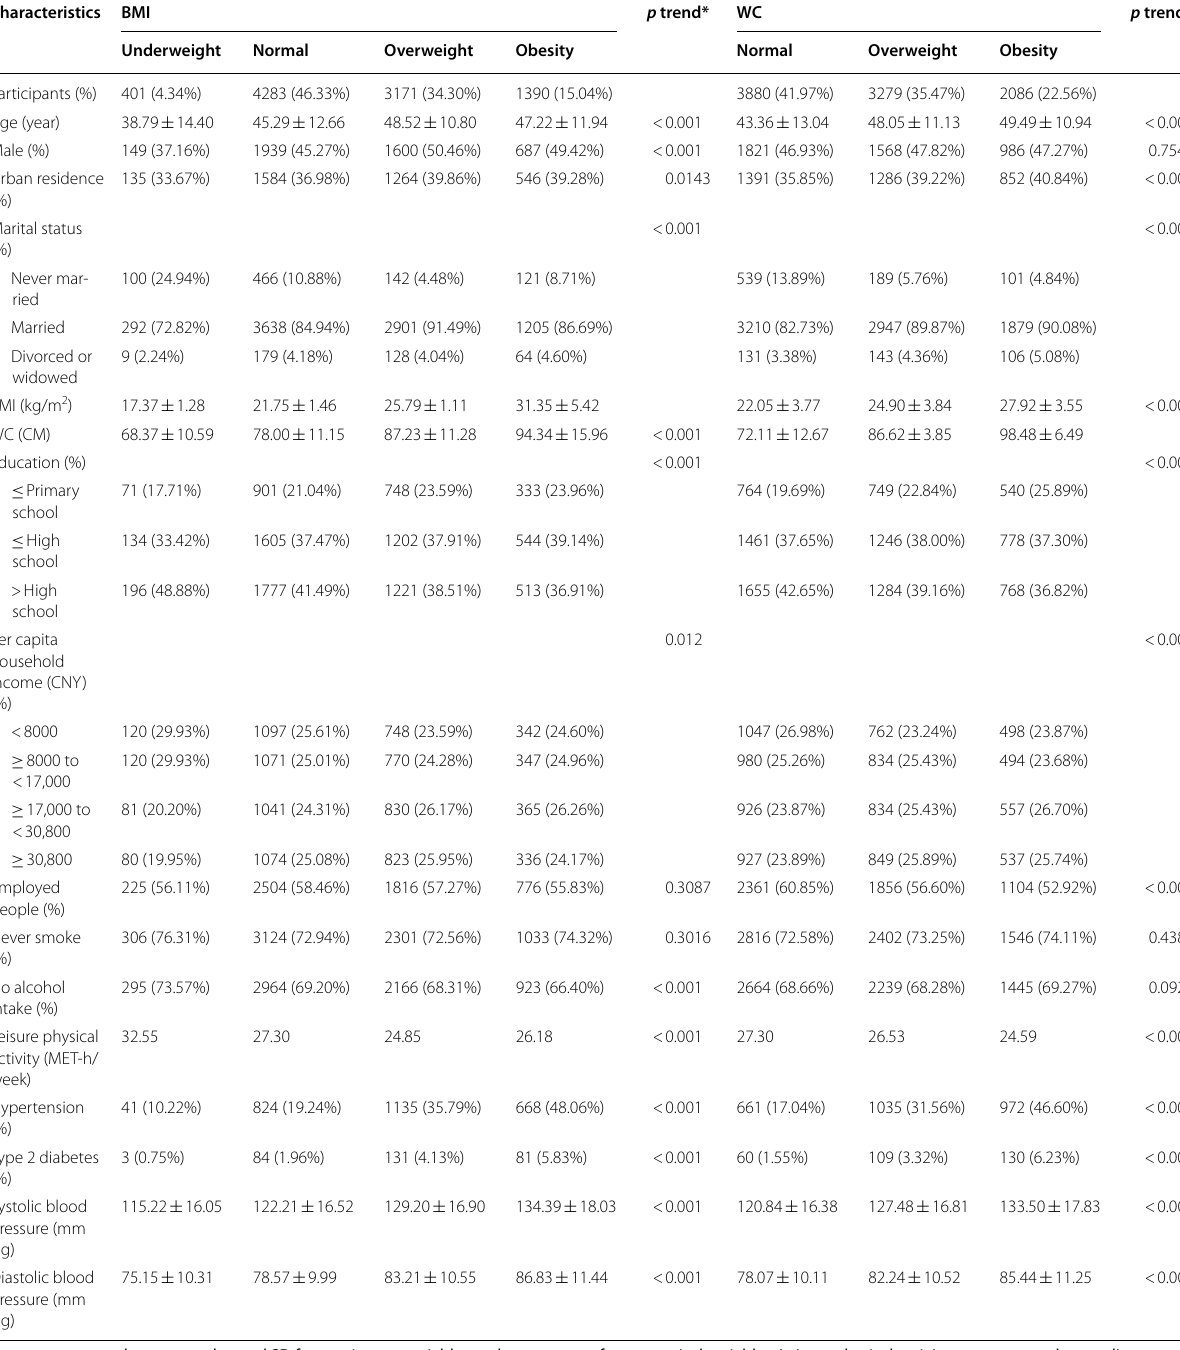
Table 1 Characteristics for 9245 participants according to body mass index (BMI) and waist circumference